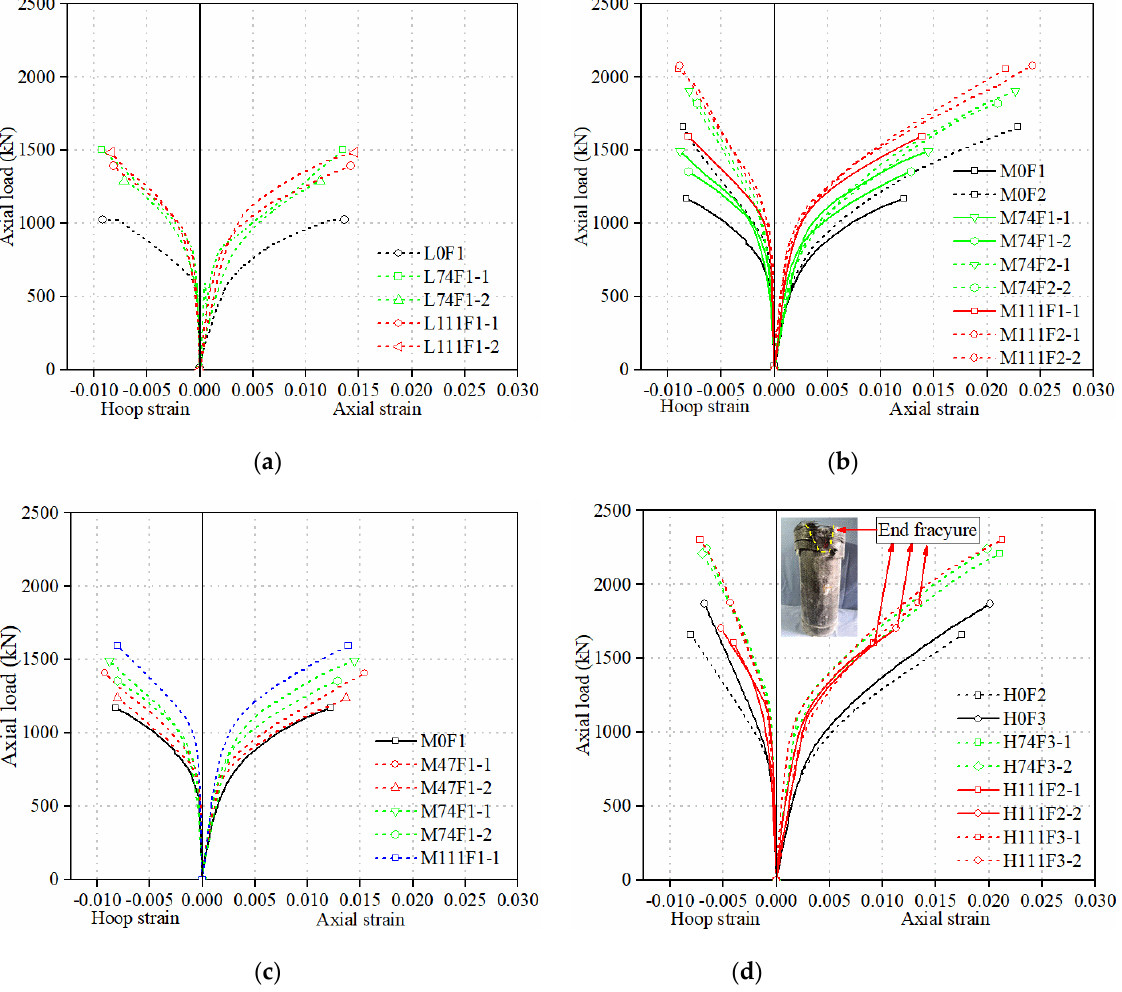
Figure 8. Axial load–axial strain curves of all test specimens: ( a ) series L; ( b ) series M with different confinement strength; ( c ) series M with different relative diameter ratios; ( d ) series H.